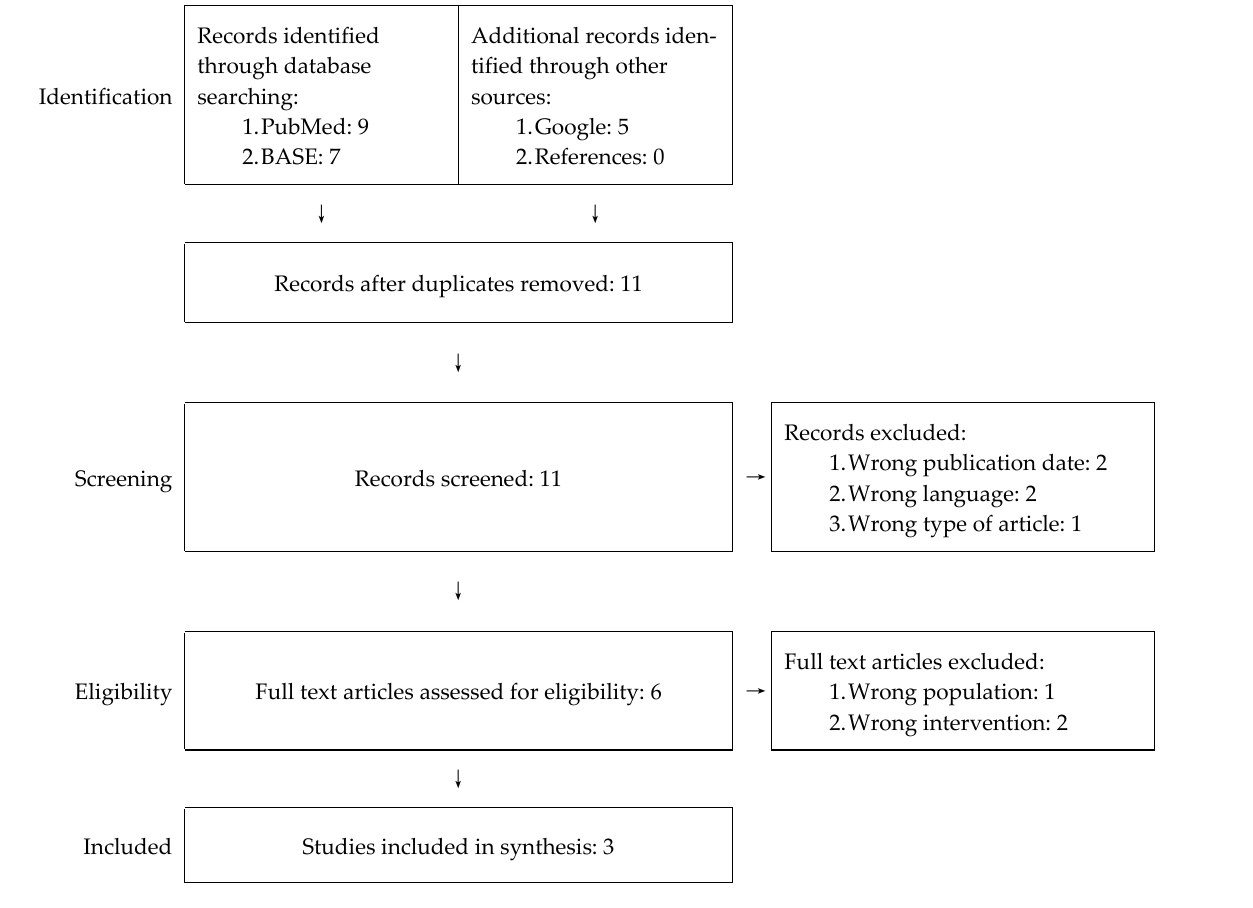
Figure 3. PRISMA flowchart for our systematic review.